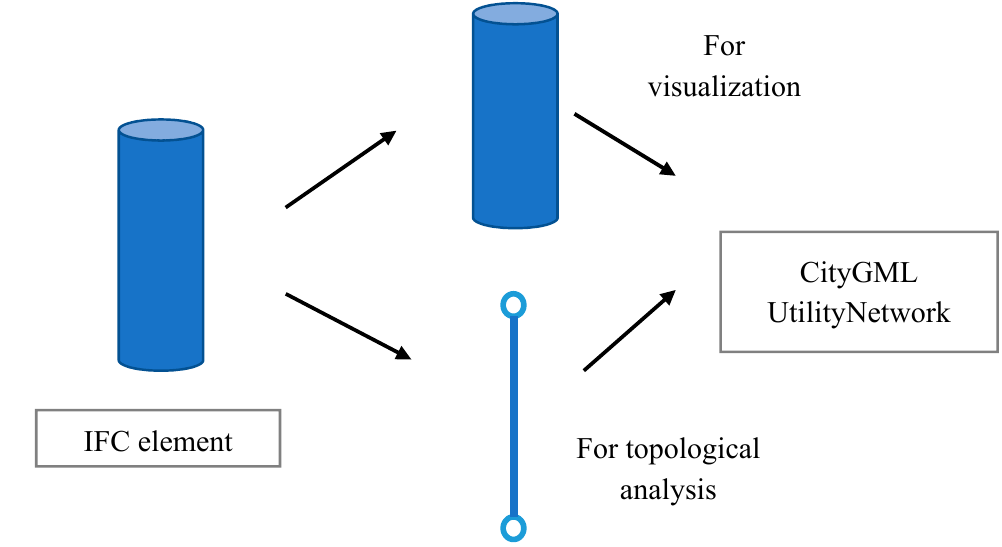
Figure 4. IFC data extracted to CityGML.